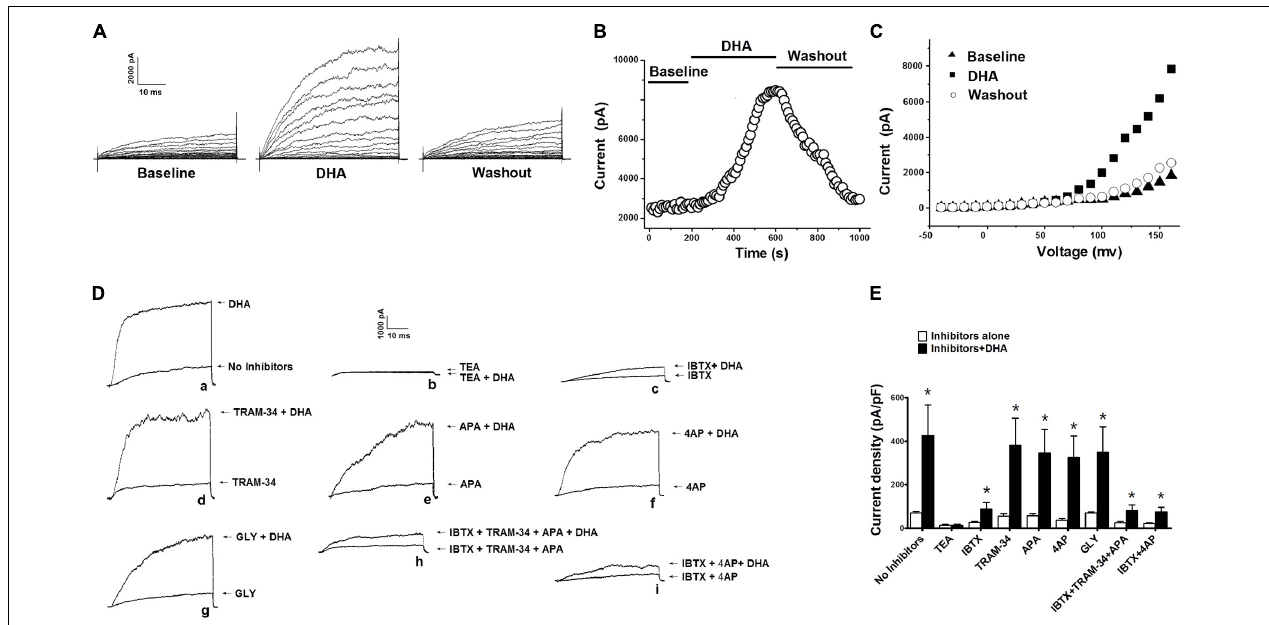
FIGURE 1 | Effects of 5 µ M DHA on total K + currents in CASMCs. (A) Representative current traces showing outward K + currents recorded from freshly isolated rat CASMCs at baseline, after exposure to 5 µ M DHA, and after DHA washout. (B) Plot showing the time course of the experiment in A . (C) I – V relationship of total K + currents at baseline, with application of 5 µ M DHA, and after DHA washout. (D) Activation of total outward K + currents in rat CASMCs by 5 µ M DHA in the presence of various K + channel blockers. Representative current traces showing the activation of total K + currents in freshly isolated rat CASMCs by 5 µ M DHA in the presence of various K + channel blockers. (E) Group data in bar graphs, n = 5 cells, ∗ P < 0.05 inhibitors alone vs. inhibitors +